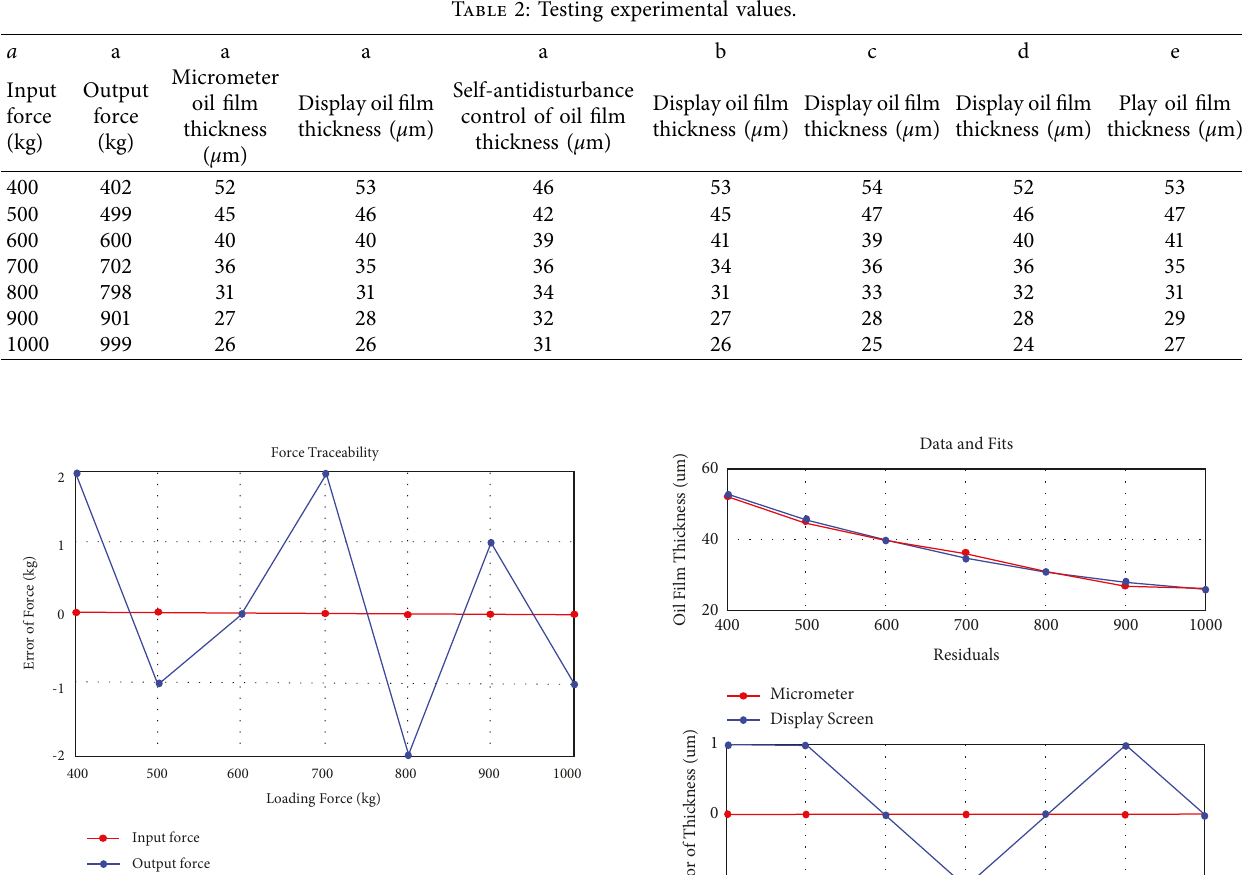
Figure 39: Force following effect.